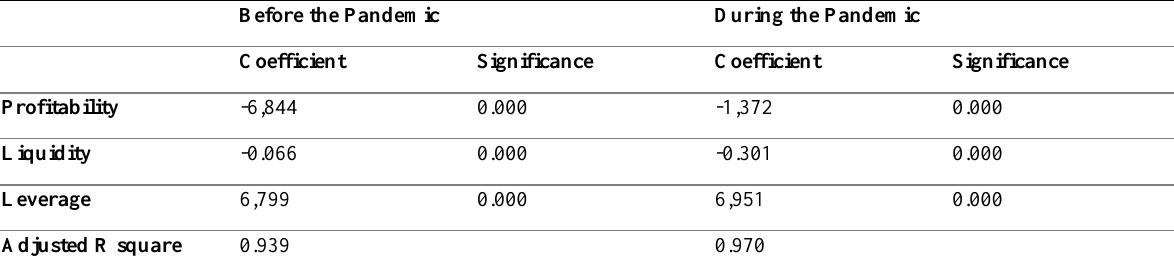
Table 4 : Regression Test Results Before and During the